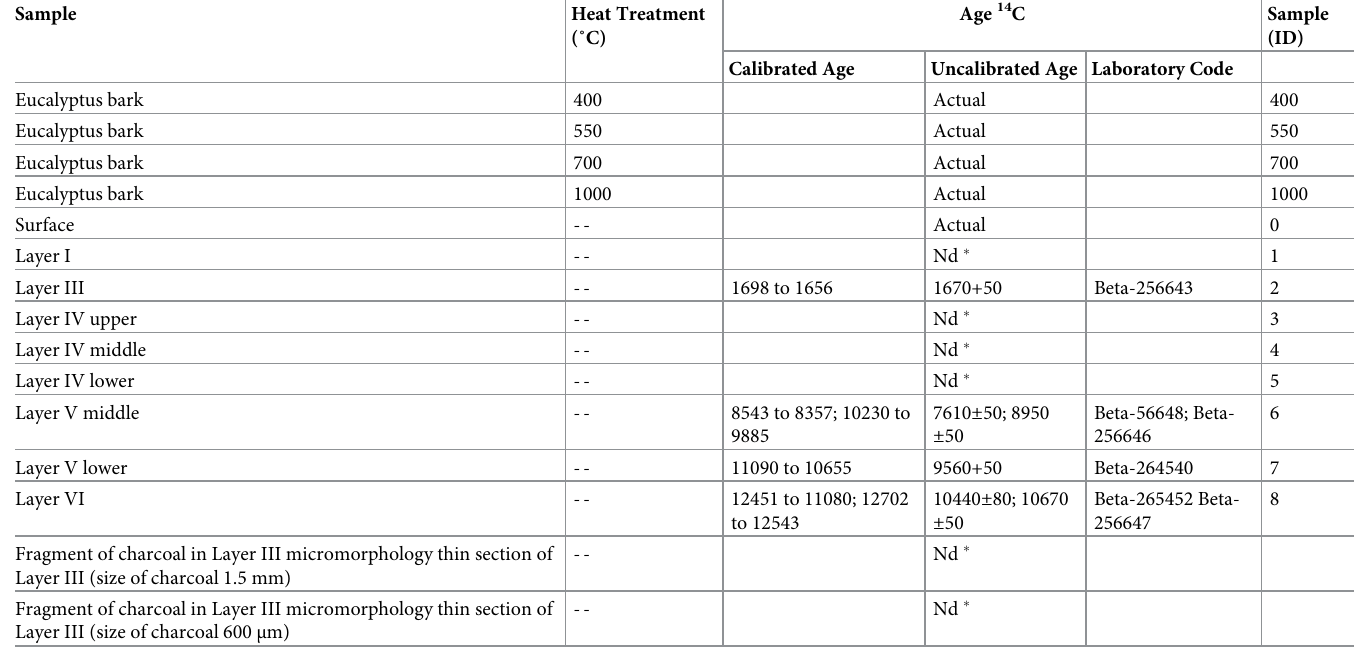
Table 1. Samples used in this